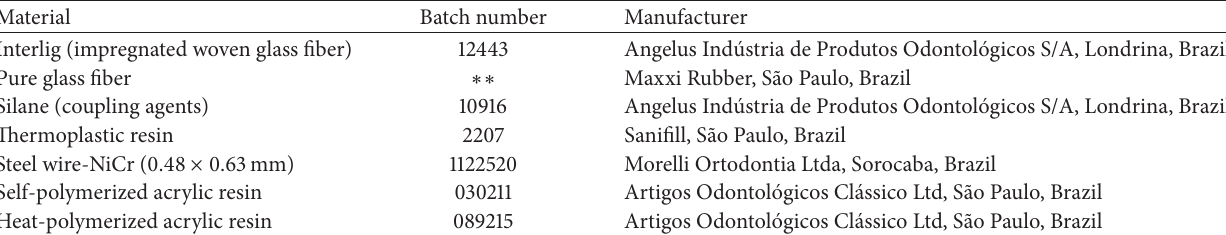
Table 1: Materials used in this